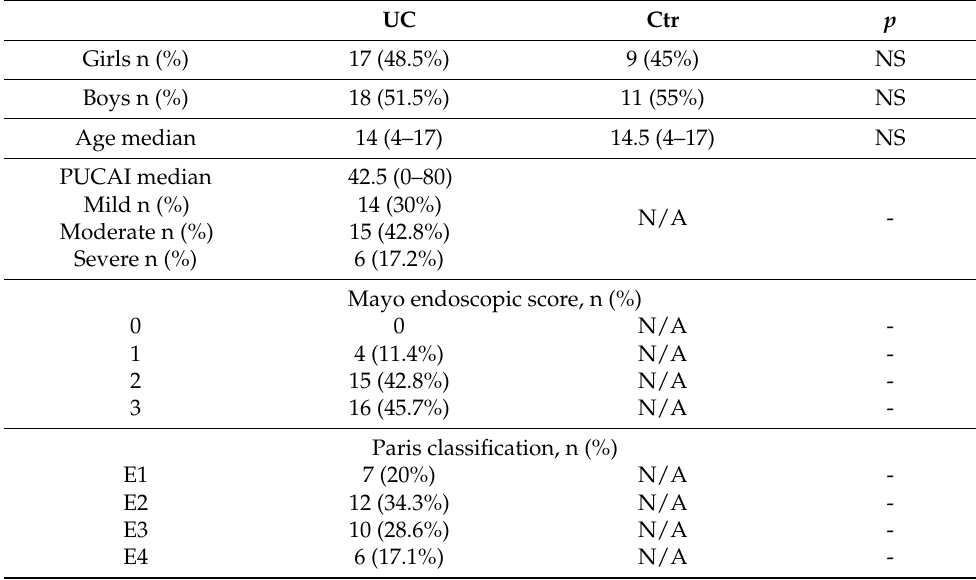
Table 1. Clinical characteristics of children with UC and